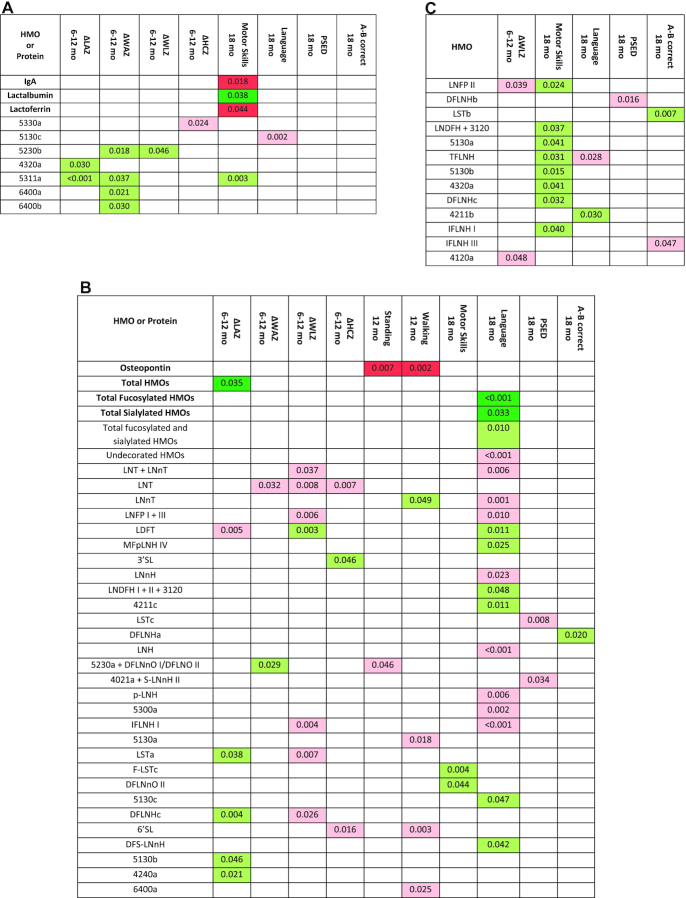
Associations of human milk oligosaccharides (HMOs) and bioactive proteins at 6 mo with infant growth and development in 659 Malawian mother-infant dyads: (A) in all participants for milk constituents that did not differ between secretors and nonsecretors; and in secretors (B) and nonsecretors (C) for milk constituents that differed between secretors and nonsecretors, or for which there was a significant interaction between the milk constituent and secretor status. Only shown are the milk constituents that were significantly associated with ≥1 of the outcomes. Bioactive proteins and groups of HMOs in bold are primary analyses; nonbolded HMOs are exploratory analyses. All numbers are P values determined by linear regression. All models were adjusted for baseline maternal age, height, BMI, parity, education, food security, HIV status, hemoglobin, household assets, and residential location, as well as infant sex and season at the time of sample collection. Associations in dark green are primary analyses that were in the positive direction and remained significant after the Benjamini–Hochberg correction for multiple hypothesis testing. Associations in light green are exploratory HMOs that were in the positive direction. Associations in pink are exploratory HMOs that were in the negative direction. Associations in red are primary analyses that were in the negative direction and remained significant after the Benjamini–Hochberg procedure. HMOs identified by numbers have not been previously named. Their composition is given as hexose, N-acetylhexosamine (HexNAc), fucose, N-acetylneuraminic acid (sialic acid). For example, 5311 has 5 hexoses, 3 HexNAc, 1 fucose, and 1 sialic acid. Thus, those with a nonzero number in the last position are sialylated; those with a nonzero number in the 3rd position are fucosylated. A-B correct, A-not-B working memory and executive function test; DFLNH, difucosyllacto-N-hexaose; DFLNnO, difucosyllacto-N-neooctaose; DFLNO, difucosyllacto-N-octaose; DFS-LNnH, difucosylmonosialyllacto-N-neohexaose; F-LST, fucosyl-sialyllacto-N-tetraose; HMO, human milk oligosaccharide; IFLNH, fucosyl-para-lacto-N-hexaose; LDFT, lactodifucotetraose; LNDFH, lacto-N-difucohexaose; LNFP, lacto-N-fucopentaose; LNH, lacto-N-hexaose; LNnH, lacto-N-neohexaose; LNnT, lacto-N-neotetraose; LNT, lacto-N-tetraose; LST, sialyllacto-N-tetraose; MFpLNH, fucosyl-para-lacto-N-hexaose; p-LNH, para-lacto-N-hexaose; PSED, profile of socioemotional development score; S-LNnH, sialyllacto-N-neohexaose; TFLNH, trifucosyllacto-N-hexaose; ΔHCZ, change in head circumference z-score; ΔLAZ, change in length-for-age z-score; ΔWAZ, change in weight-for-age z-score; ΔWLZ, change in weight-for-length z-score; 2′FL, 2′-fucosyllactose; 3′FL, 3′-fucosyllactose; 3′SL, 3′-sialyllactose; 6′SL, 6′-sialyllactose.